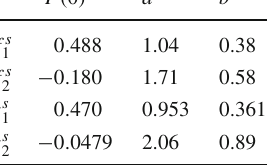
Table 2 The (cid:2) b → (cid:2) c form factors given in the three-parameter form